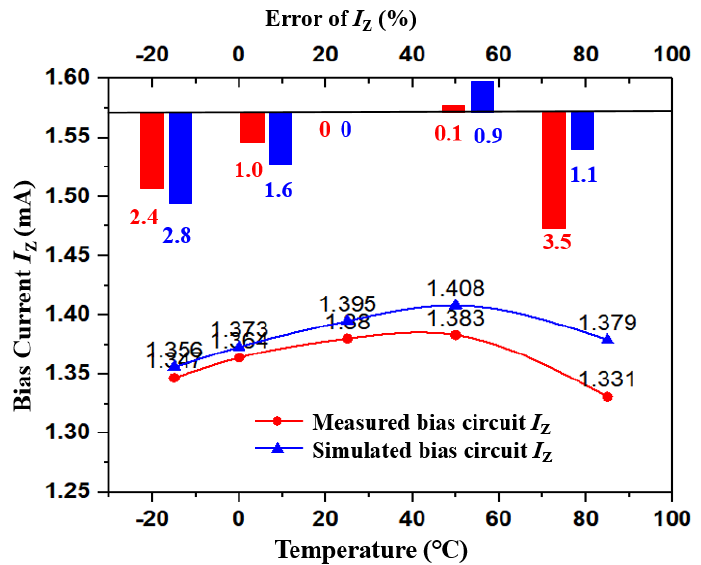
Figure 8. Measured and simulated ZTAT currents over temperature.